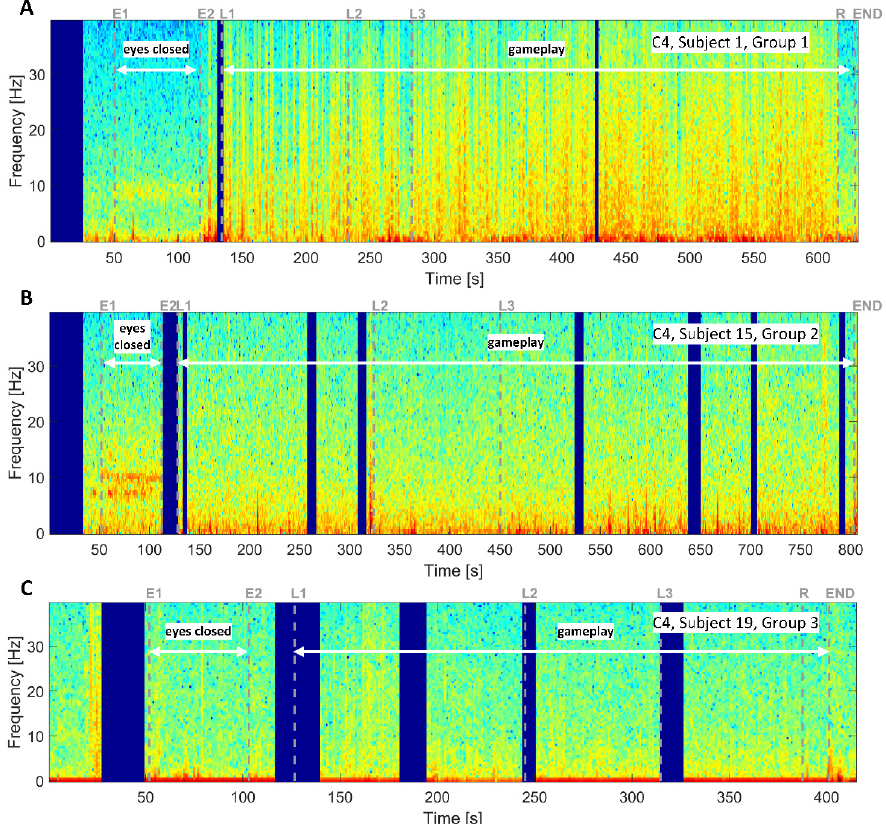
Figure 9. The representative spectrograms for three groups of subjects. Representative spectrogram of group 1 ( A ), representative spectrogram of group 2 ( B ), and representative spectrogram of group 3 ( C ).